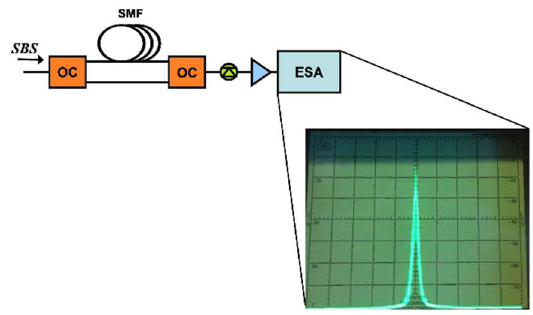
Fig. 3. Self-heterodyne method .